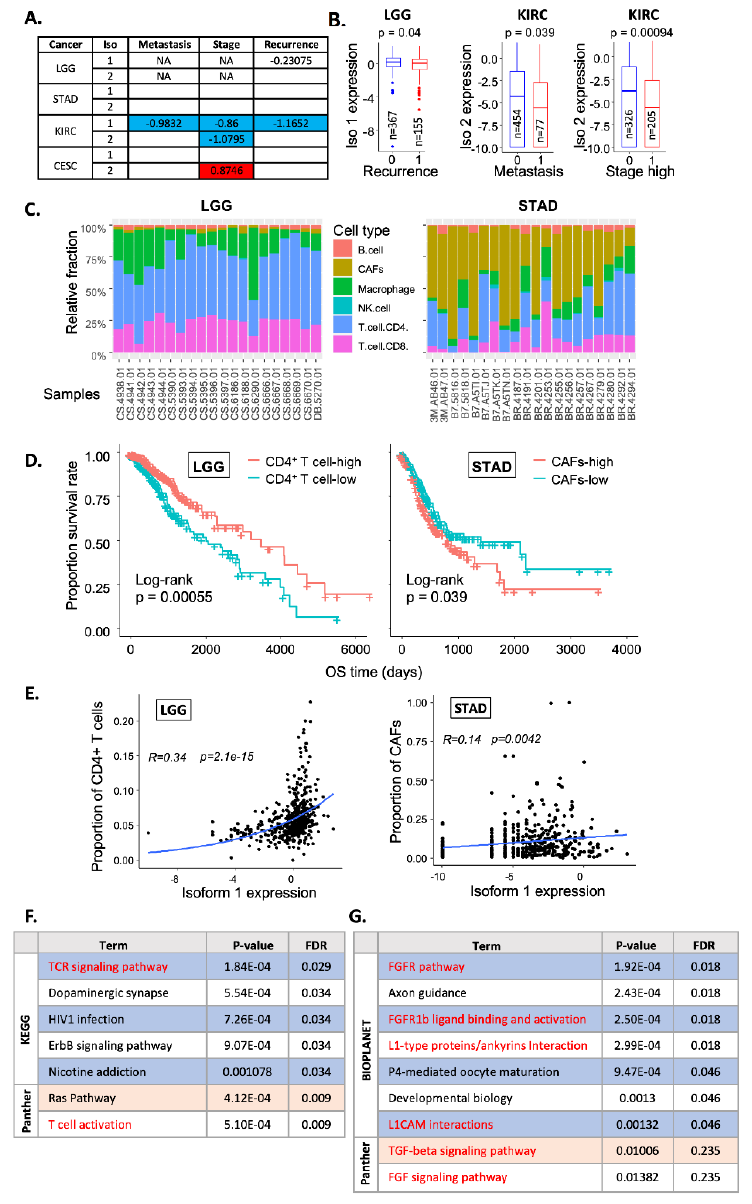
Figure 4. Correlation of RSK4 isoform expression with clinical features. ( A ) Spearman correlation of RSK4 isoform expression with the metastatic status, stage, and recurrence in LGG, STAD, KIRK, and CESC patients. Numbers represent correlation coefficients, with blue indicating statistically significant negative and red positive correlations. NA, clinical features not provided. ( B ) Box plot showing RSK4 isoform expression versus cancer recurrence in LGG, and metastatic status and high stage (III and IV) in KIRK patients. 0, no event; 1, event; n, number of patients. Statistics: Wilcoxon test. ( C ) Stacked bar plots of inferred cell type fractions from the EPIC deconvolution algorithm for the first 20 samples for LGG and STAD in the TCGA dataset. ( D ) Kaplan–Meier curves with log-rank test for the association between CD4 + T cell or CAFs fractions and the overall survival of LGG and STAD patients, respectively. ( E ) Spearman correlation was used to examine the correlation between isoform 1 expression and proportion of CD4 + T cells in LGG patients and CAFs in STAD patients. R represents correlation coefficient. ( F , G ) The top 100 genes co-expressed with RSK4 isoform 1 (Spearman correlation, Rho > 0.55 and adjusted p -value < 0.05) were subjected to pathway enrichment analysis in EnrichR and terms from databases showing p ≤ 0.05 are displayed. Terms highlighted in red are associated with T cell ( F ) and CAF ( G )